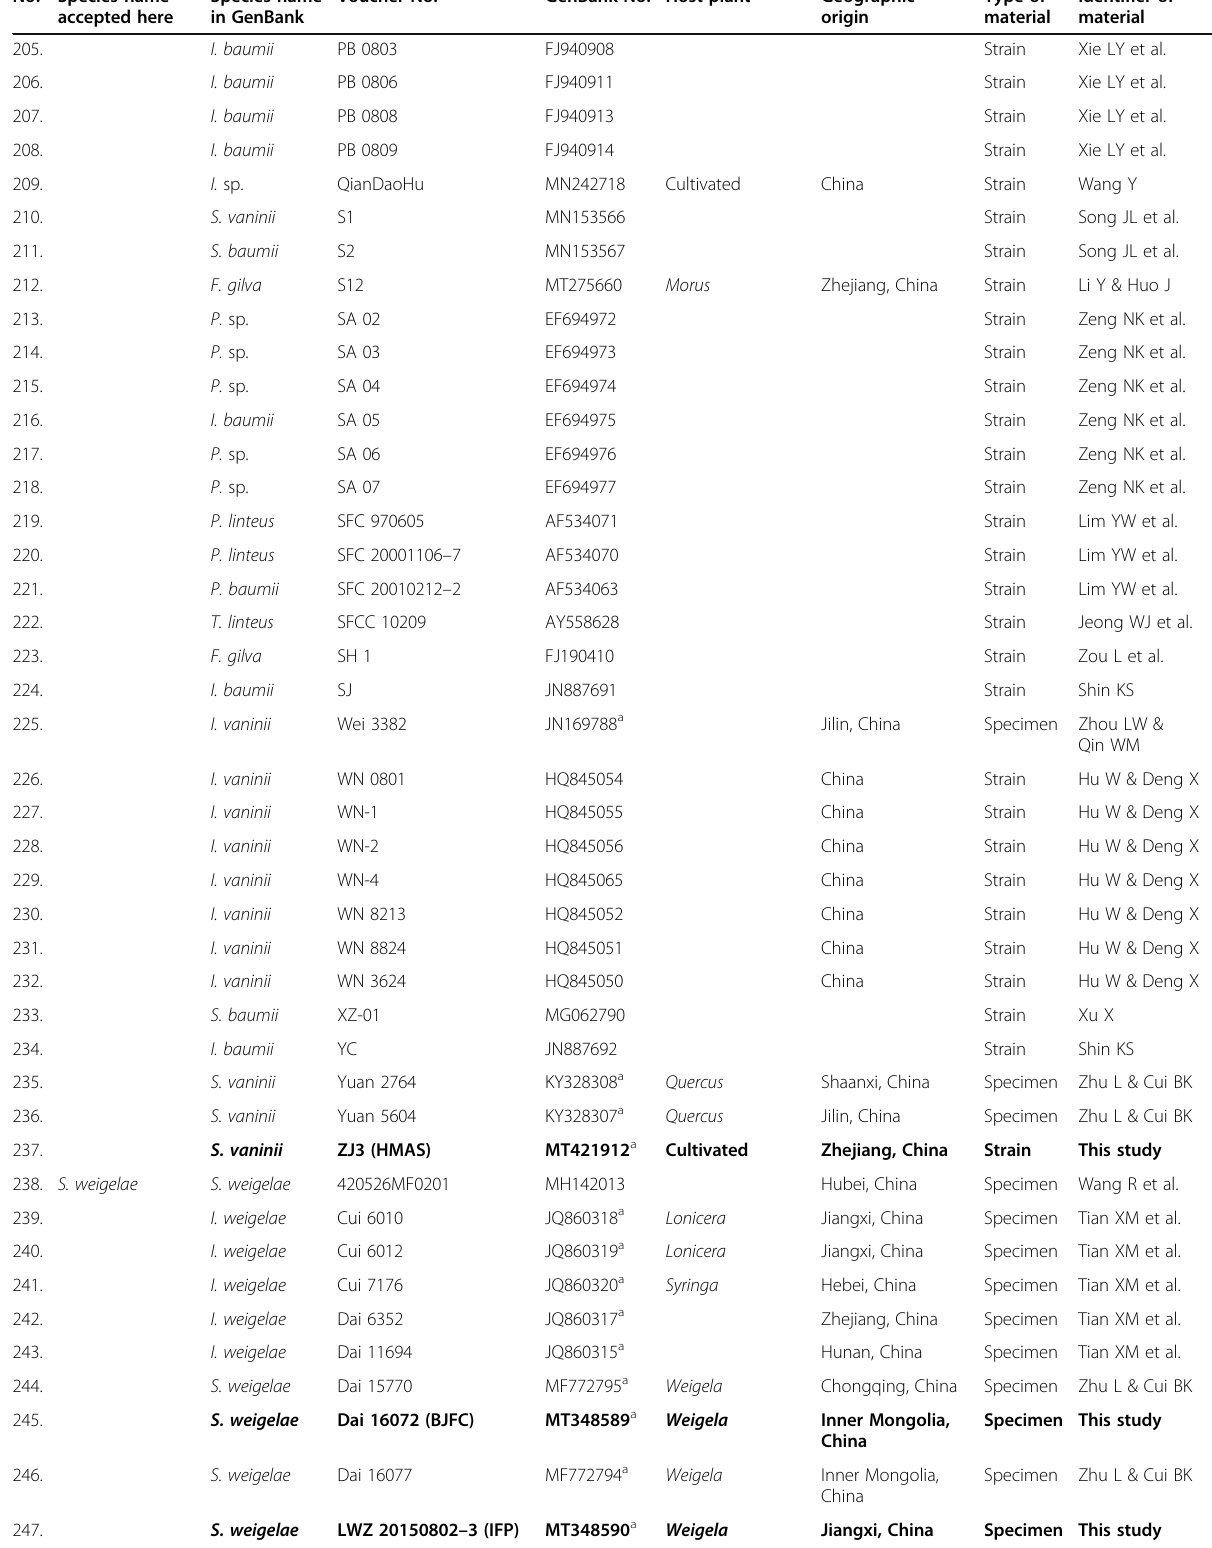
Table 1 Information of analyzed ITS sequences of Sanghuangporus